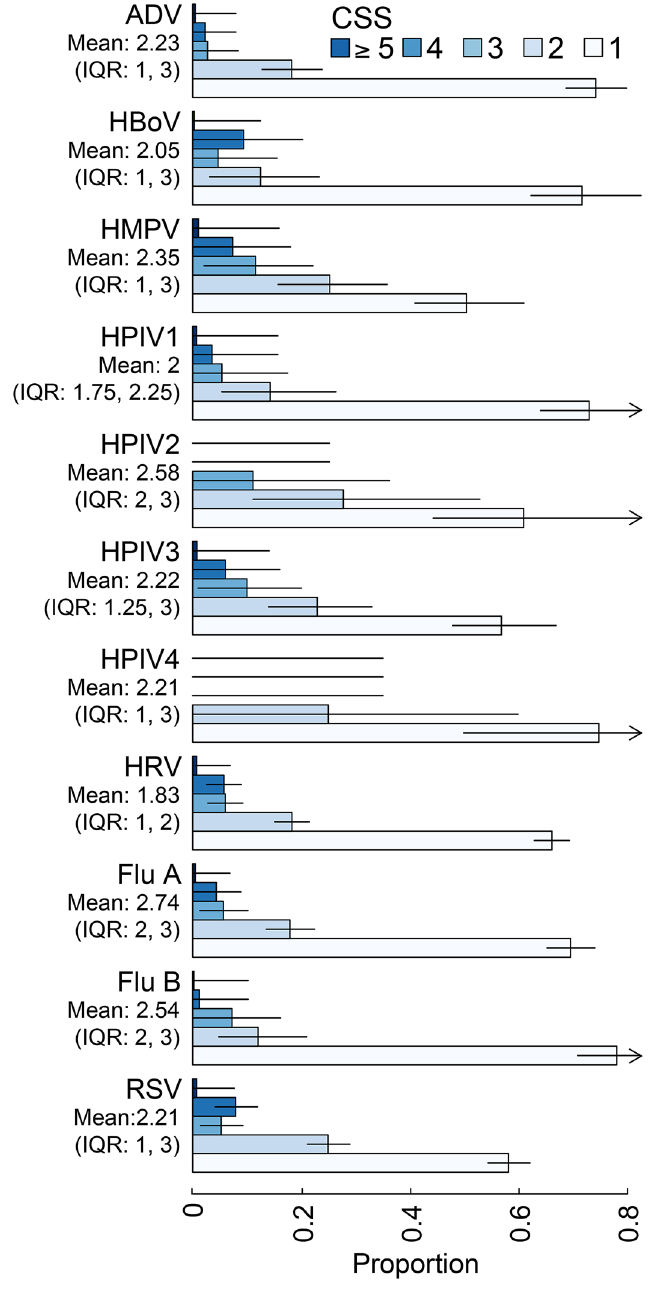
Figure 2. Distribution of CSS by virus. Figure shows the distributions (counts) of CSS by virus. Multinomial confidence intervals are calculated using the method of Sison and Graz 23 , as implemented in the R package 24 . ADV Adenovirus, HBoV Human bocavirus, HMPV Human metapneumoviruses, HPIV- MultinomialCI 1, -2, -3, -4 Human parainfluenza viruses 1–4, HRV Human rhinovirus, Flu A influenza A, Flu B influenza B, RSV Respiratory syncytial